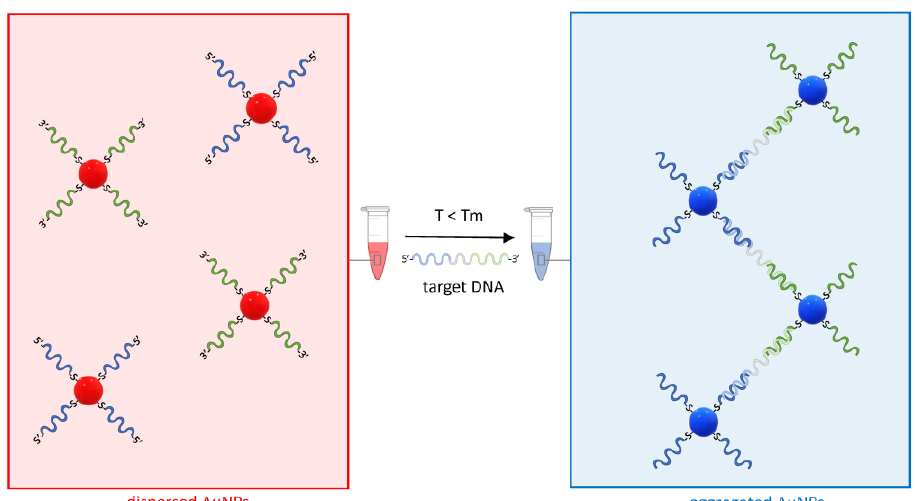
Figure 4. The principle of sandwich hybridization for the detection of nucleic acids using AuNP – ASOs. On the left, two distinct sets of AuNP – ASOs are represented by the blue and green ssDNA molecules conjugated via a thiol – gold bond to the AuNPs at the 5′ or 3′ end. In presence of a target DNA complementary to both ASOs and a temperature T below the melting temperature Tm of the ASOs, the AuNPs undergo aggregation, and the red color typical of a dispersed solution of AuNPs shifts towards the blue (right).